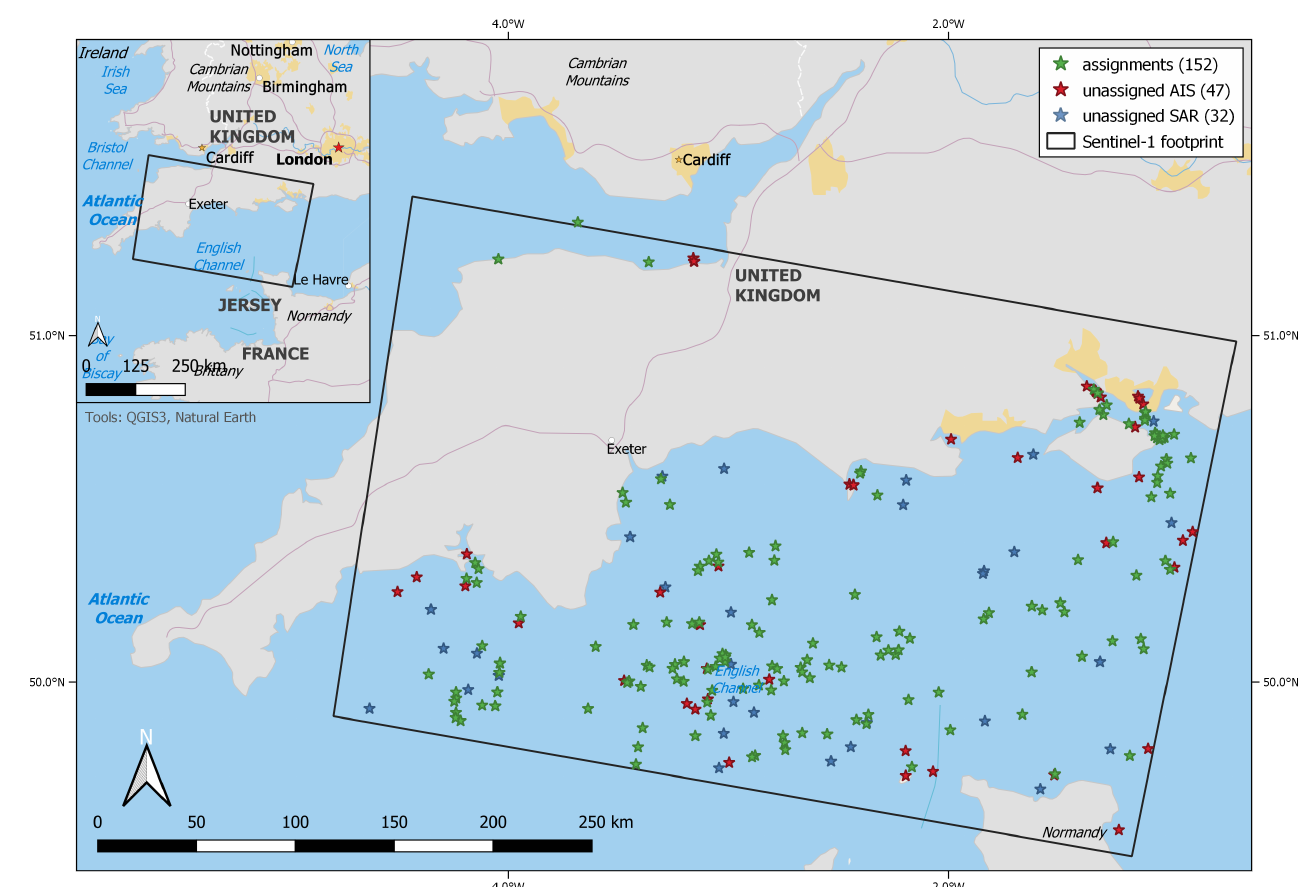
Figure 13. English Channel data